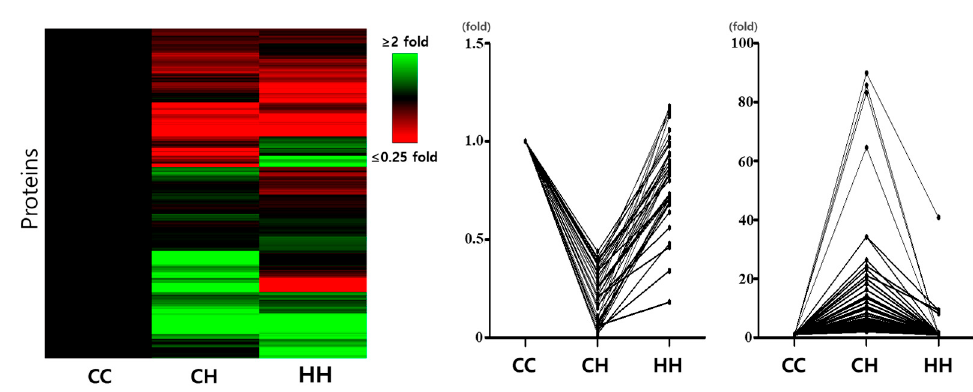
Figure 2. Heat map using di ff erentially expressed proteins and expressed patterns of positive e ff ected proteins by early heat. Each value is a fold change compared to the CC. CC: raised at a suitable temperature without heat exposure, CH: chronic heat exposed group, HH: early and chronic heat exposed